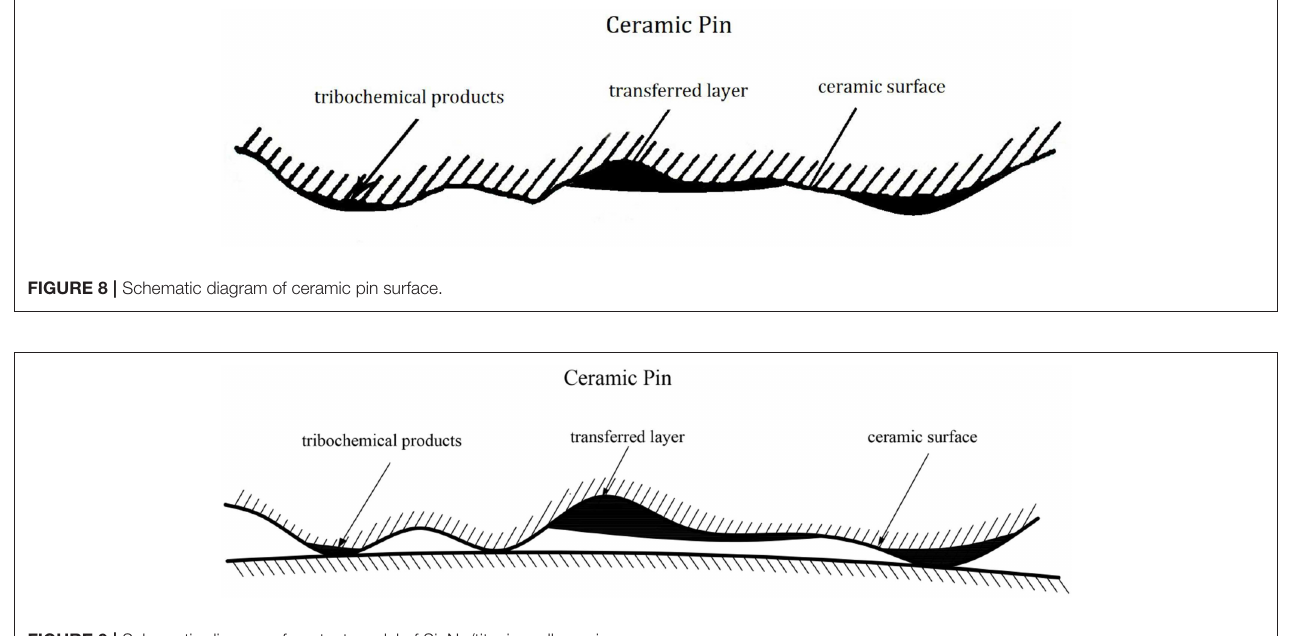
Frontiers in Materials |